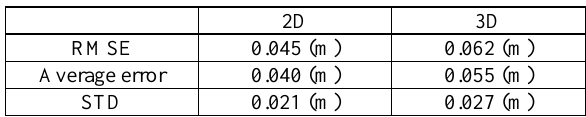
Table 5. The results of modelling polylines.